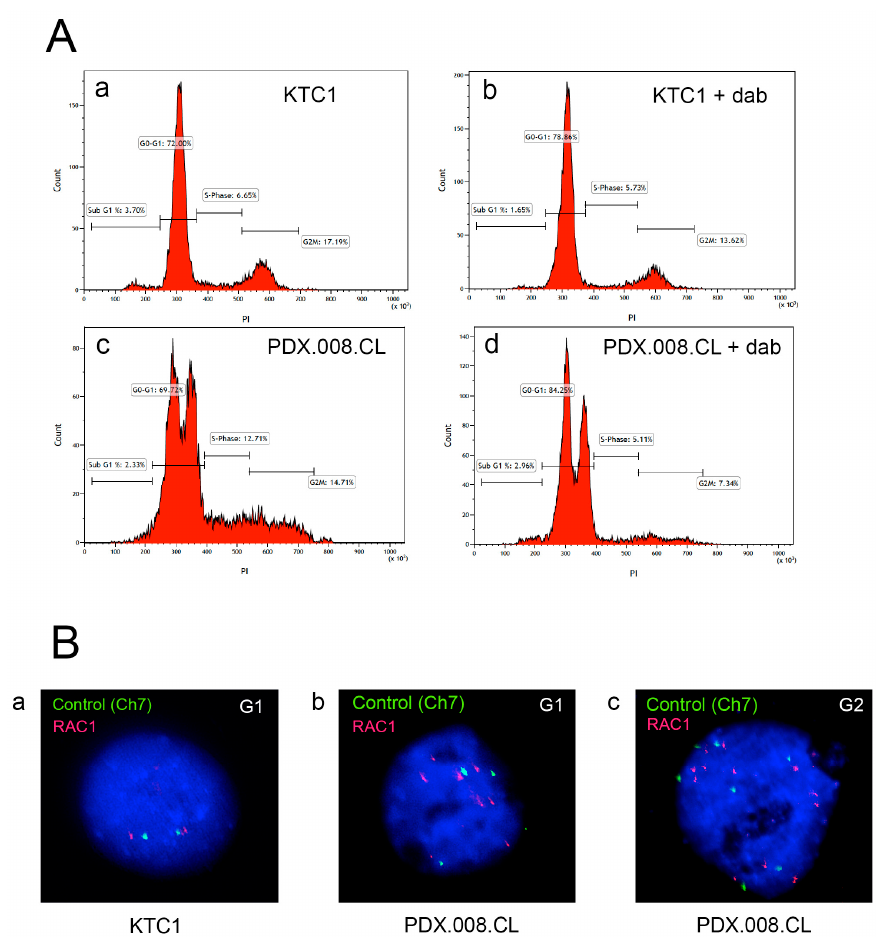
Figure 4. PDX.008.CL cells are aneuploid. ( A ) KTC1 ( a , b ) and PDX.008.CL cells ( c , d ) were analyzed by flow cytometry. KTC1 cells were diploid, showing 2N DNA at G0/G1 and 4N DNA at G2 ( a ) while PDX.008.CL cells were aneuploid, showing 2N DNA and an additional peak at G0/G1 ( c ). Dabrafenib treatment (0.1 µ M dabrafenib for 2 days) induced cell cycle arrest in both cell lines ( b , d ) as seen by an increase in the percentage of diploid cells in G0/G1. Dabrafenib reduced the percentage of aneuploid cells by ~20% ( d ). Count = cell number; PI = propidium iodide (DNA amount). ( B ) Fluorescence in situ hybridization (FISH) of KTC1 and PDX.008.CL cells with a RAC1 probe (red) and a chromosome 7 centromeric probe (green) as control. The KTC1 cell line is diploid for chromosome 7 ( a ), while the PDX.008.CL line shows chromosome 7 trisomy and additional RAC1 duplications ( b , c ).